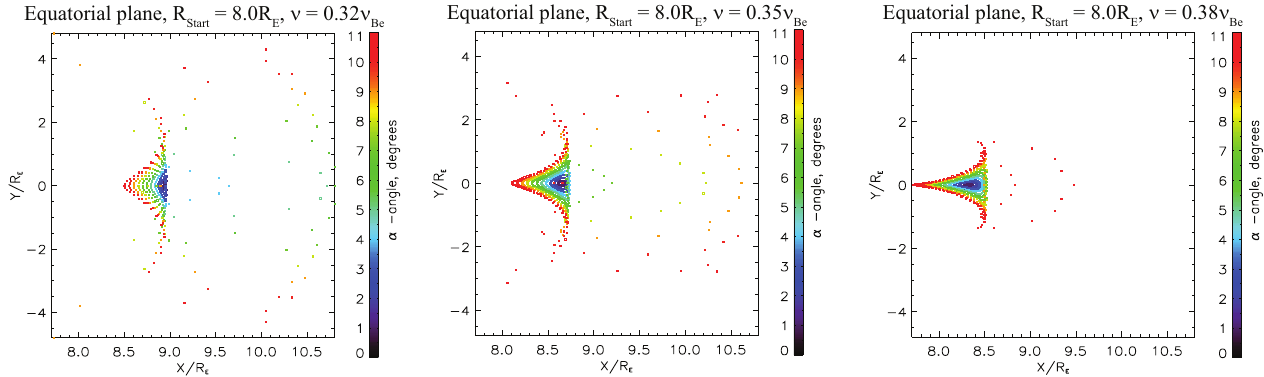
Fig. 8. Color-coded rectangles mark the points at which whistler rays intersect the plane of the magnetic equator after their first low-altitude reflection. Color outlines the initial angle between the wave’s k -vector and the ambient magnetic